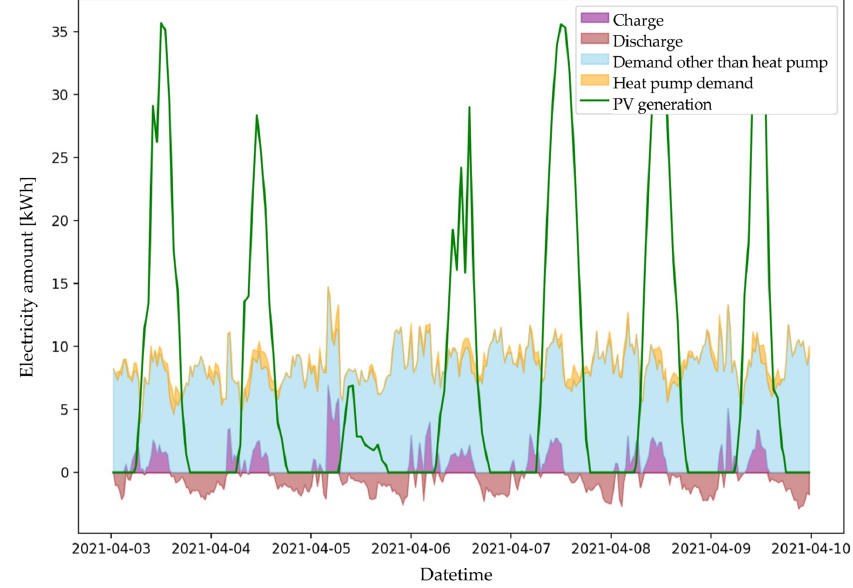
Figure 12. Demand changes for one week without P2P transactions (Scenario 1).